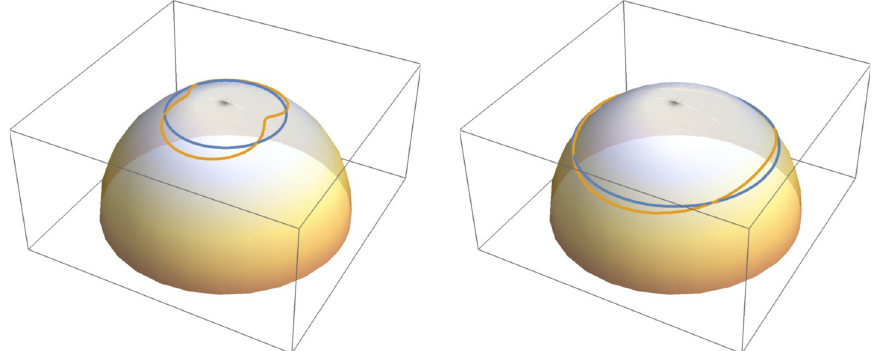
Figure 2 . Giant gravitons at the vacuum (blue) and excited (orange) states. We put j = 0 . 8 for the left and j = 0 . 4 for the right figure. Other parameters are R = 1 , (cid:15) = 0 . 05 , c = 1 , d = 0 .